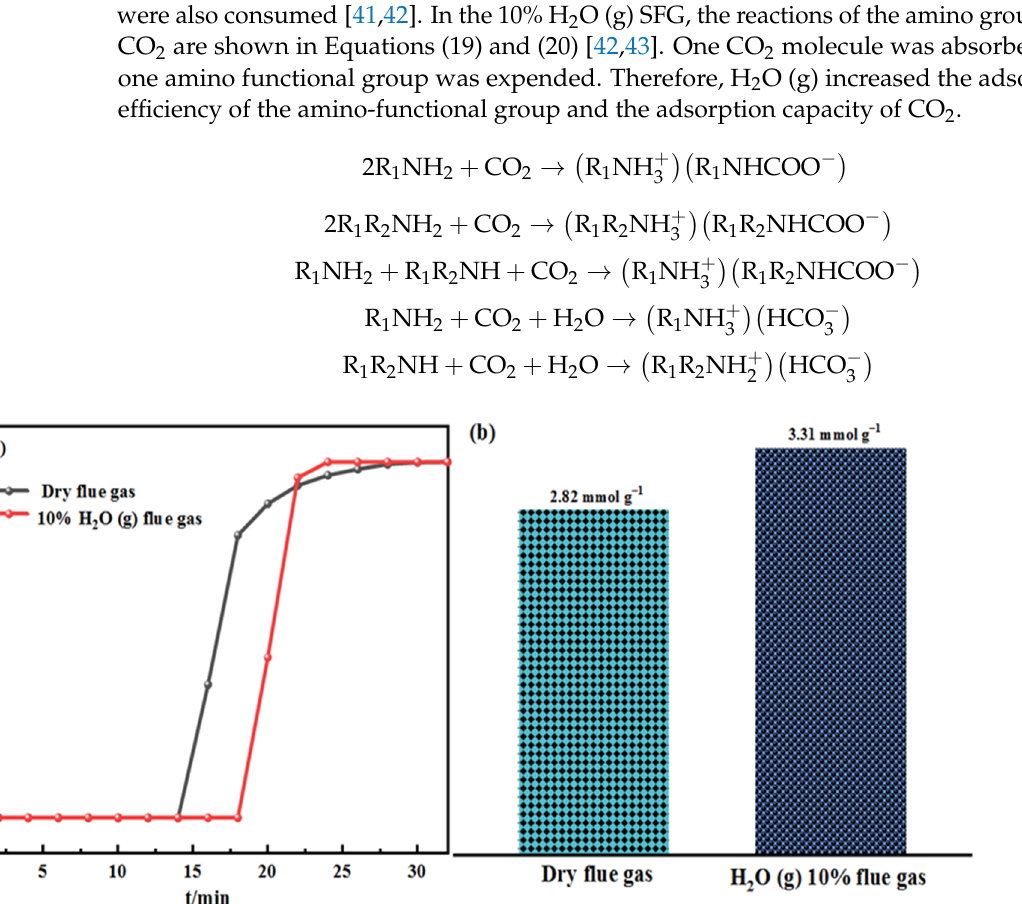
Figure 8. ( a ) Breakthrough adsorption curves and ( b ) adsorption capacity of CBC-50-TEPA in different SFGs.